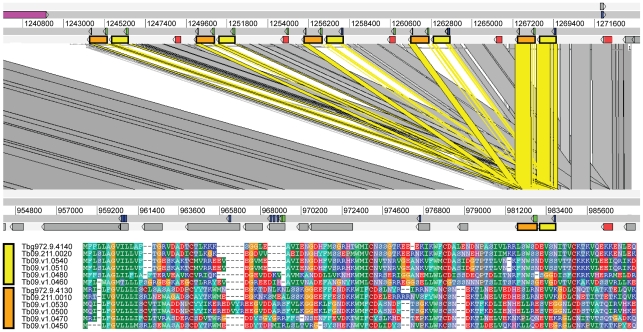
Segmental duplication on chromosome 9 in T. b. brucei.A single segment in T. b. gambiense comprising three coding sequences (Tbg972.9.4160, 4140 and 4130) corresponds to a three-gene segmental duplication (5 repeats) on chromosome 9 in T. b. brucei. The first coding sequence (shaded red) is a conserved, hypothetical gene encoding a putative secretory protein and all copies are identical. The second (shaded yellow) and third (shaded orange) coding sequences are tandem-duplicate, conserved hypothetical genes encoding putative membrane-bound proteins. Both second and third genes contain substantial sequence variation in T. b. brucei; the upstream-most copies are orthologous to the T. b. gambiense genes, but none of the remaining variants were identified among T. b. gambiense sequence reads. The segmental duplication is preceded immediately upstream by an INGI-mediated insertion (shaded purple).